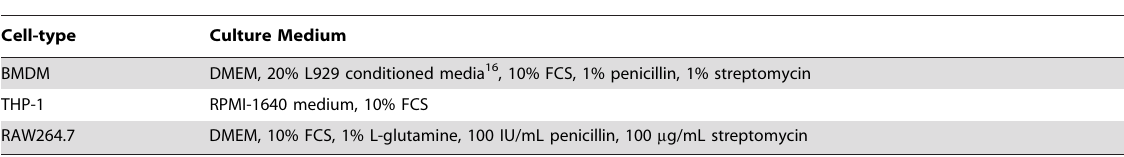
Table 2. All samples were normalised against hypoxanthine guanine phosphoribosyl transferase housekeeping gene expression.